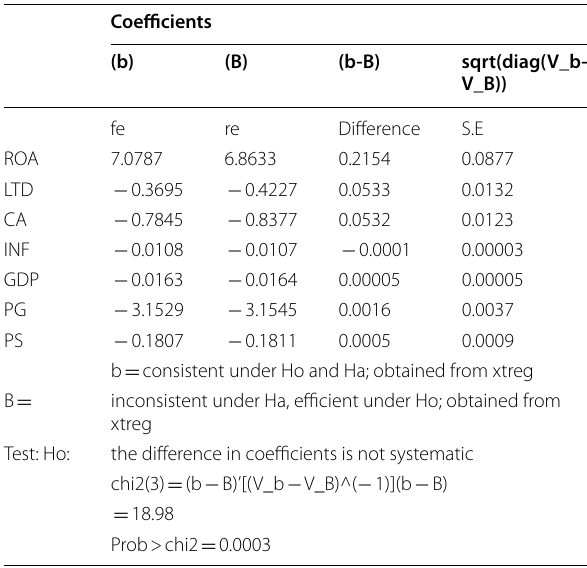
Table 5 Model specification test